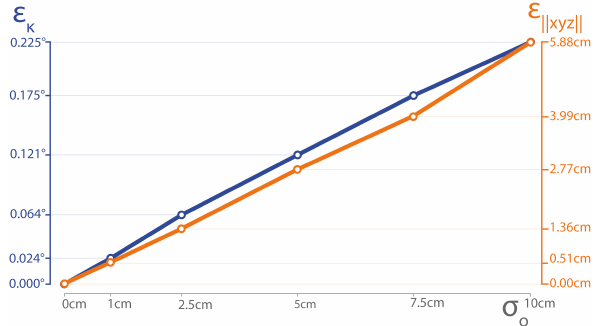
Figure 6: Errors in registration using 3D entities in the case of a hall. 50 sample tests per case. Orange: error in position. Blue: error in